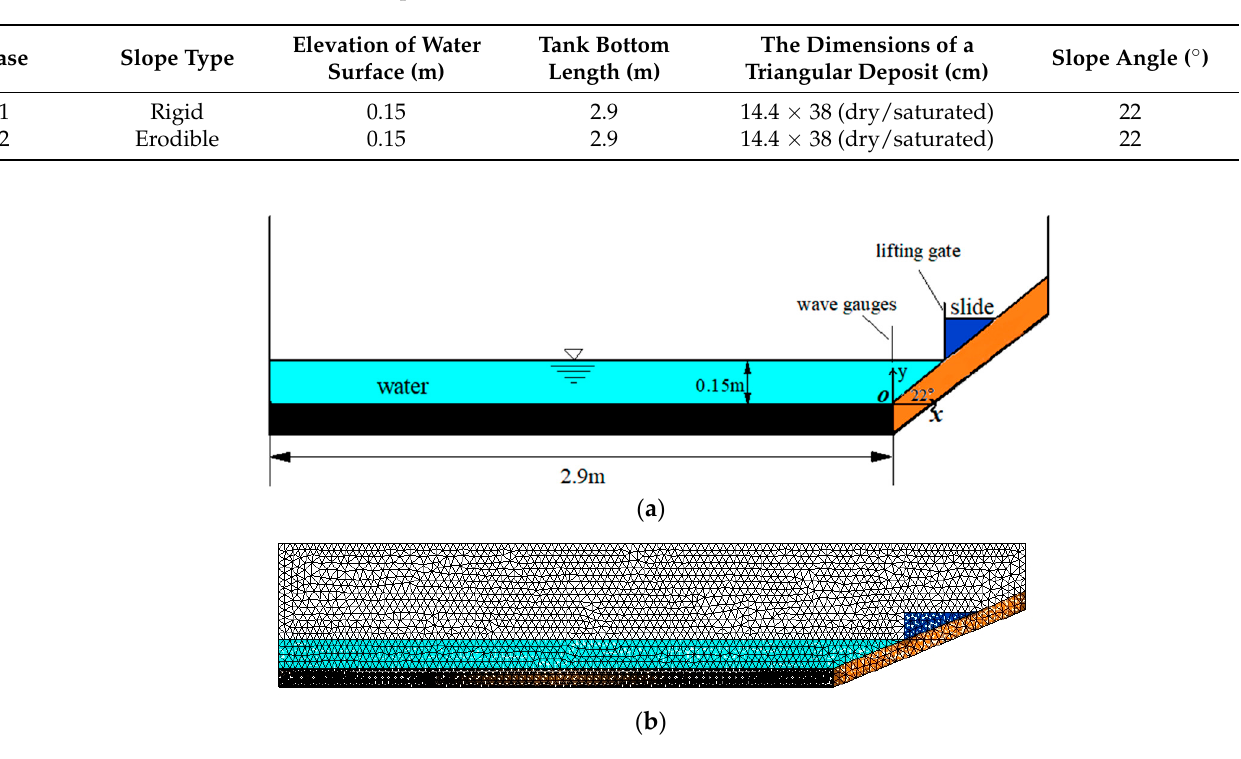
Table 2. Material parameter.